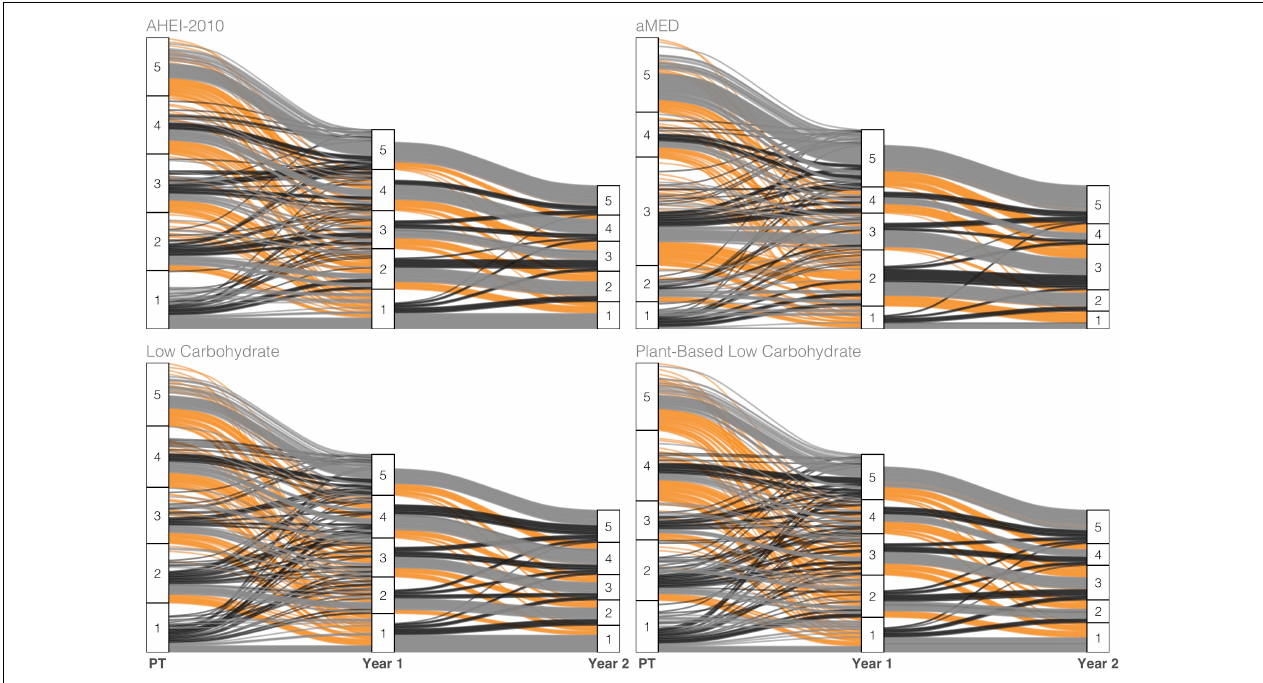
FIGURE 1 | Alluvial plot tracking subject-specific diet index scores of select indices across the three measurement points—pretreatment (PT), 1 year, and 2 years post-diagnosis—of observation. The color scheme maps to three classes of change observed across adjacent years: Increase (black), no change (gray), or decrease (orange) in ranking.